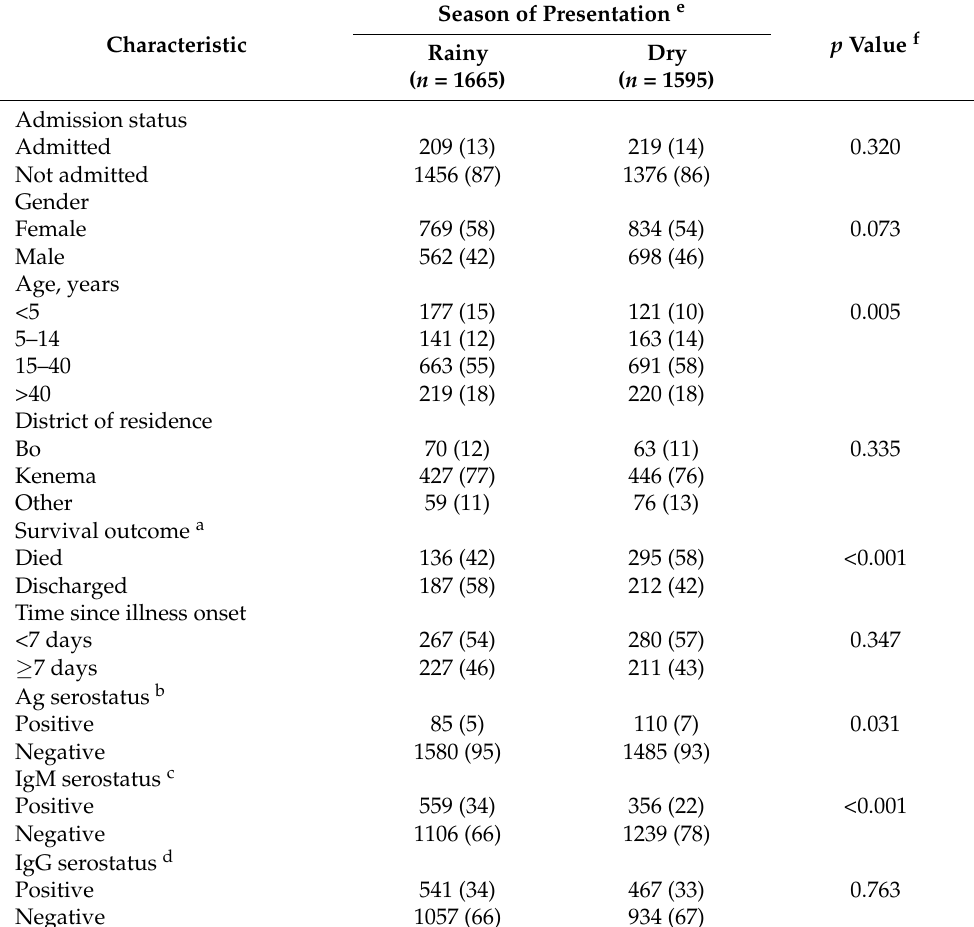
Table 2. Characteristics of suspected Lassa fever screenings by season of clinical presentation, Kenema Government Hospital, 2012–2019. Note. All results expressed as frequencies and percentages unless indicated otherwise. Those characteristics with aggregate frequencies less than their respective aggregate serostatus group sample sizes reflect missing characteristic data. Season of Presentation e Characteristic p Value f Rainy Dry ( n = 1665) ( n =